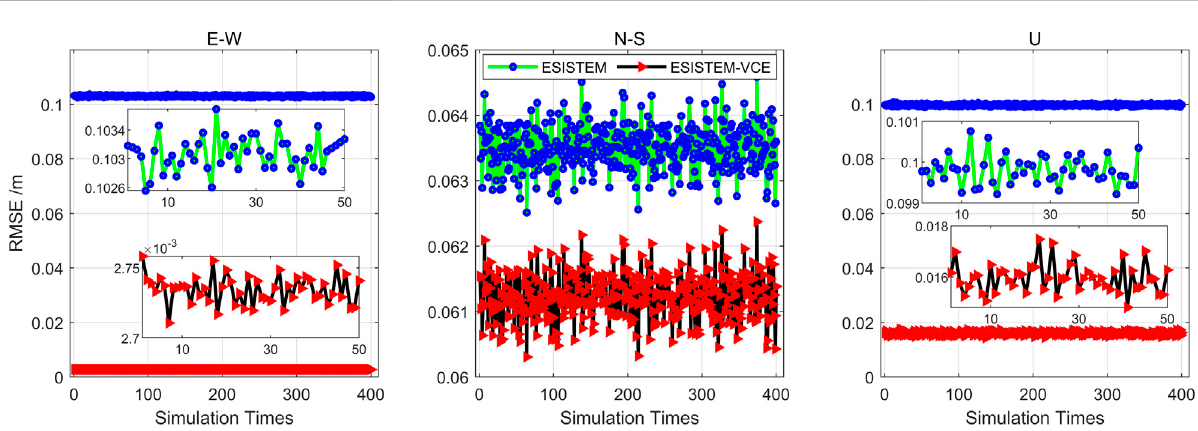
The RMSEs for three components from ESISTEM-VCE and ESISTEM methods with 400 Monte Carlo simulations. The black and green lines represent the RMSEs of the ESISTEM-VCE and ESISTEM methods, respectively. The sub fi gures in E-W and U components are partial enlarged view, respectively.